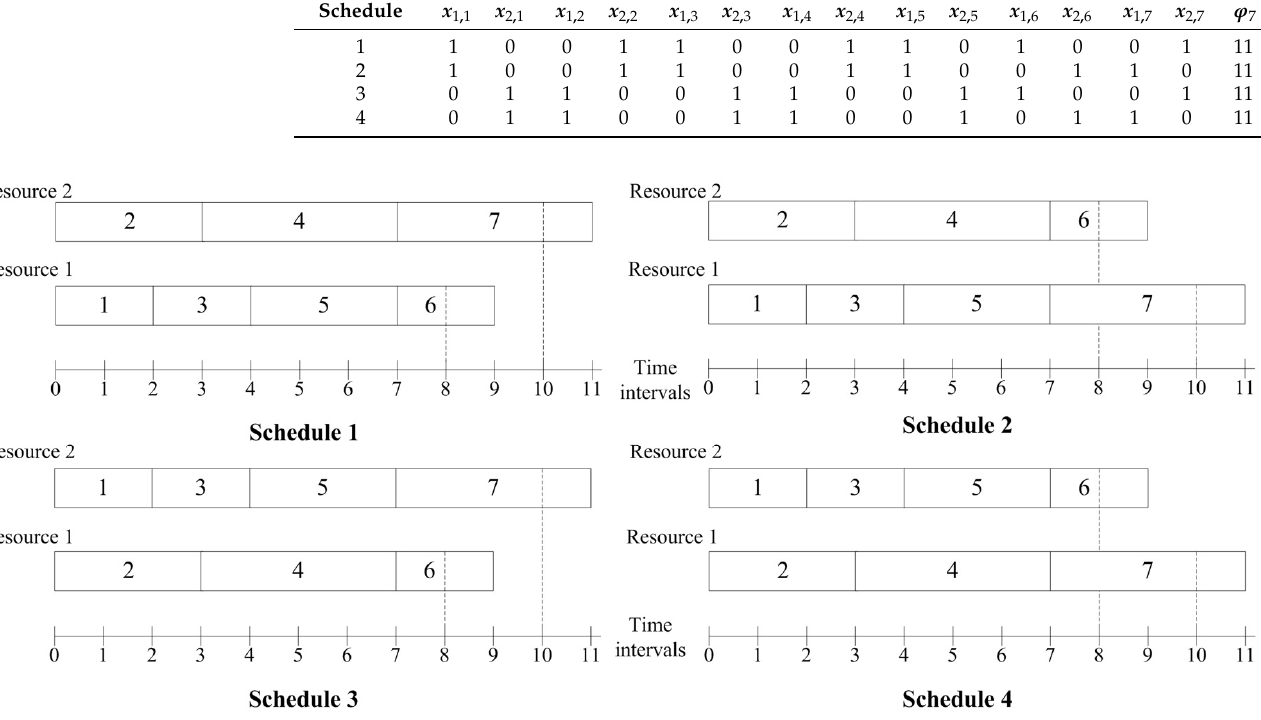
Table 4. Schedules with minimal makespan.